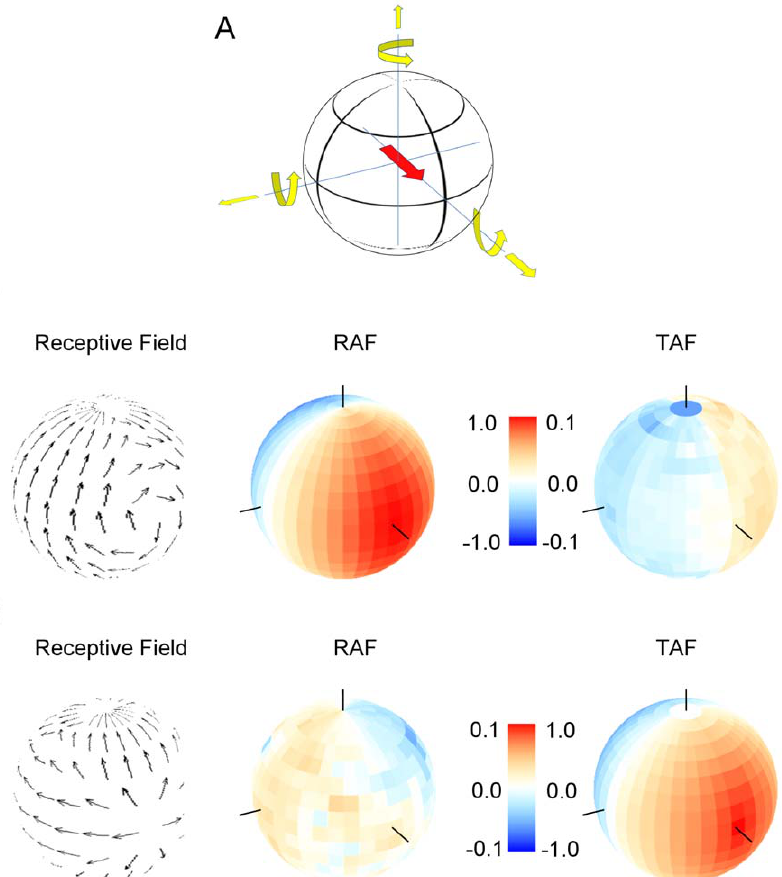
Figure 8. Rotational and translational action field of an ideal rotation (b) and translation (c) sensor. a Definition of axes. b Receptive field of an ideal roll sensor (left). Its rotational action field is strong and has a maximum in the frontal part of the visual field (middle). Its translational action is extremely weak at all positions (right). The black lines on the sphere indicate the roll, pitch, and yaw rotation axis (middle) or the translation axis for forward, sideward and upward motion (right). c Receptive field of an ideal thrust sensor (left). Its rotational action field is extremely weak at all positions (middle). Its translational action is strong and has a maximum in the frontal part of the visual field (right).